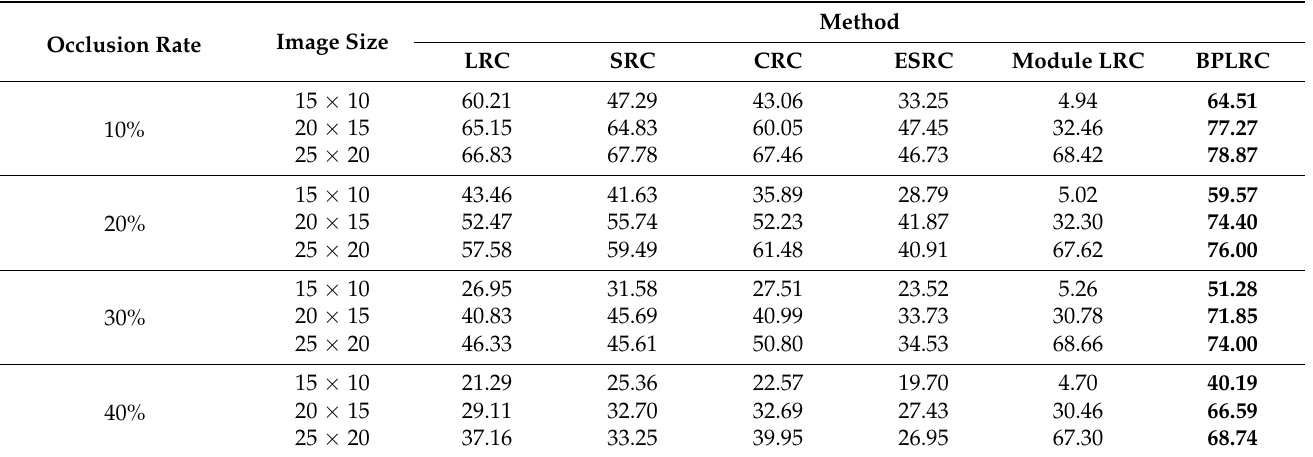
Table 4. Accuracy (%) of different methods when identifying 10%-, 20%-, 30%-, and 40%-occluded face images in the Extended Yale B database.